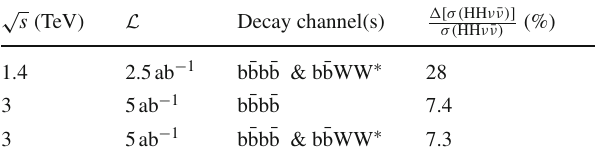
Table 5 Measurement uncertainties for the cross section of e + e − → HH ν ¯ ν at the different stages of CLIC with different collision energy √ s and integrated luminosity L including different decay channels and assuming the 4:1 polarisation scheme